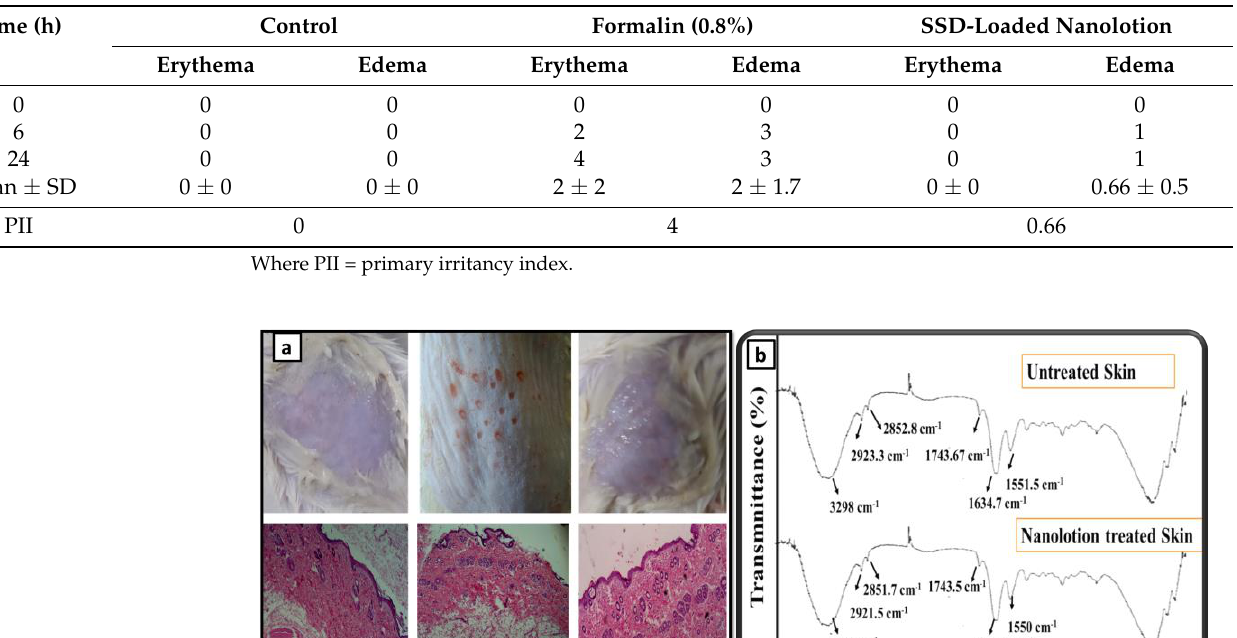
Table 4. Comparative primary irritancy index (PII) of SSD-loaded nanolotion.